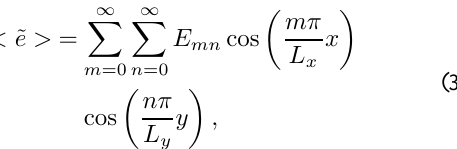
Fig. 22. The approximate intensity field with the contour plot of energy density inthe orthotropic plate when f = 1 kHzand η = 0 . 2 . The reference energy density is 1 × 10 − 12 J/m 2